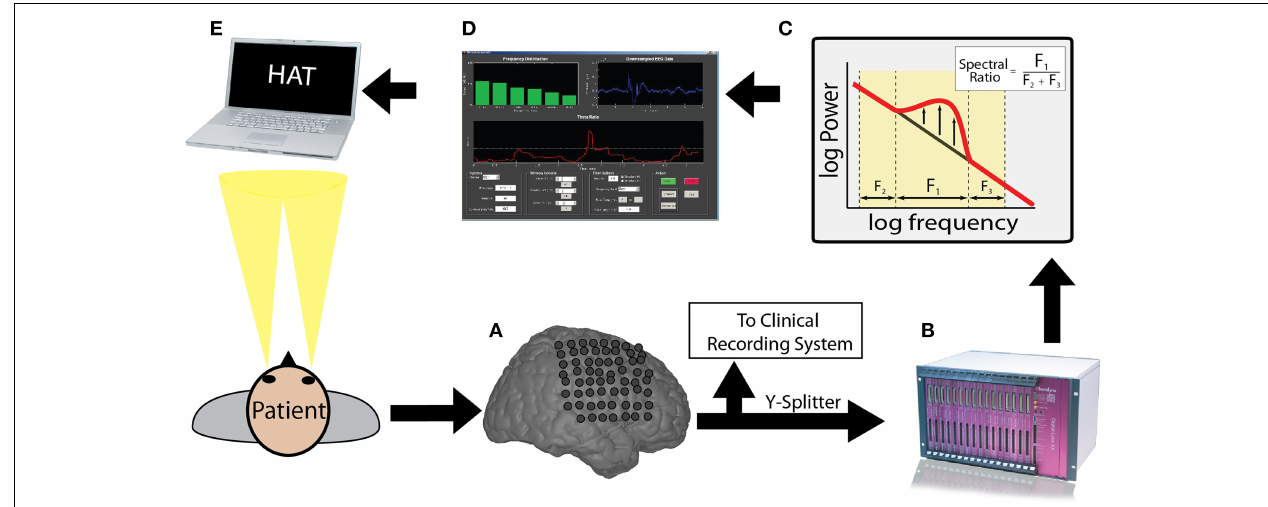
FIGURE 1 | Brain computer interface free recall task: overview. Incoming ECoG data recorded by intracranial electrodes (A) was split and digitized by a Neuralynx recording system (B) . The appropriate